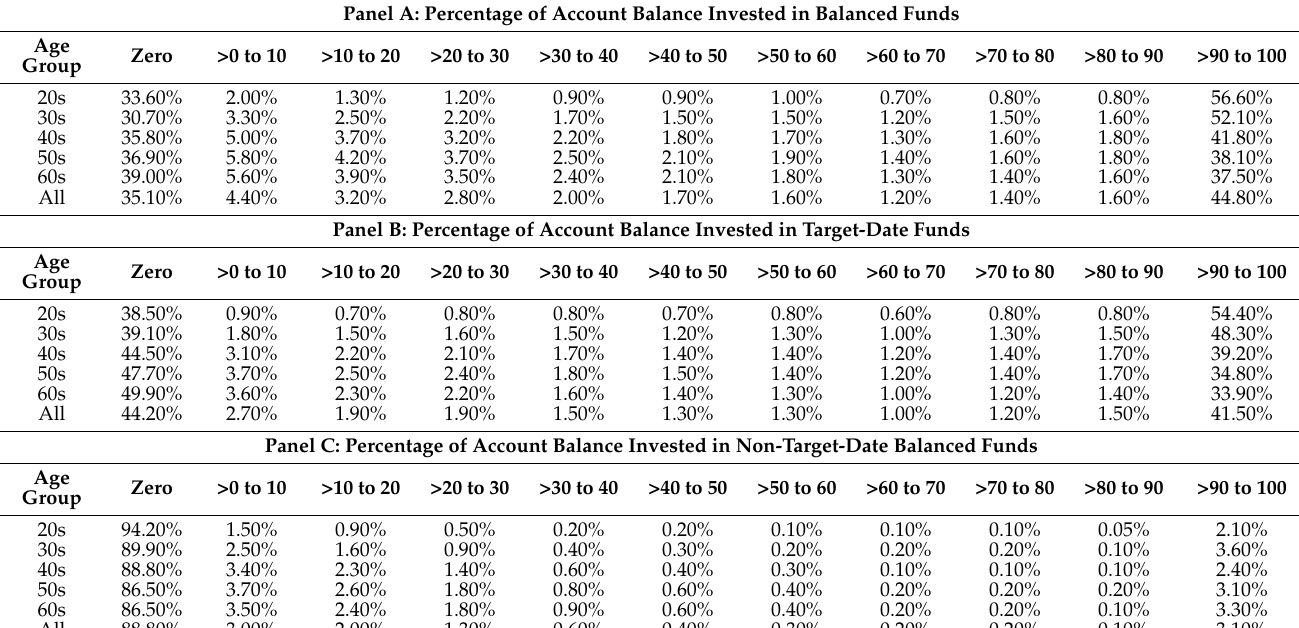
Table 1. Target Date Fund Choice by Investor